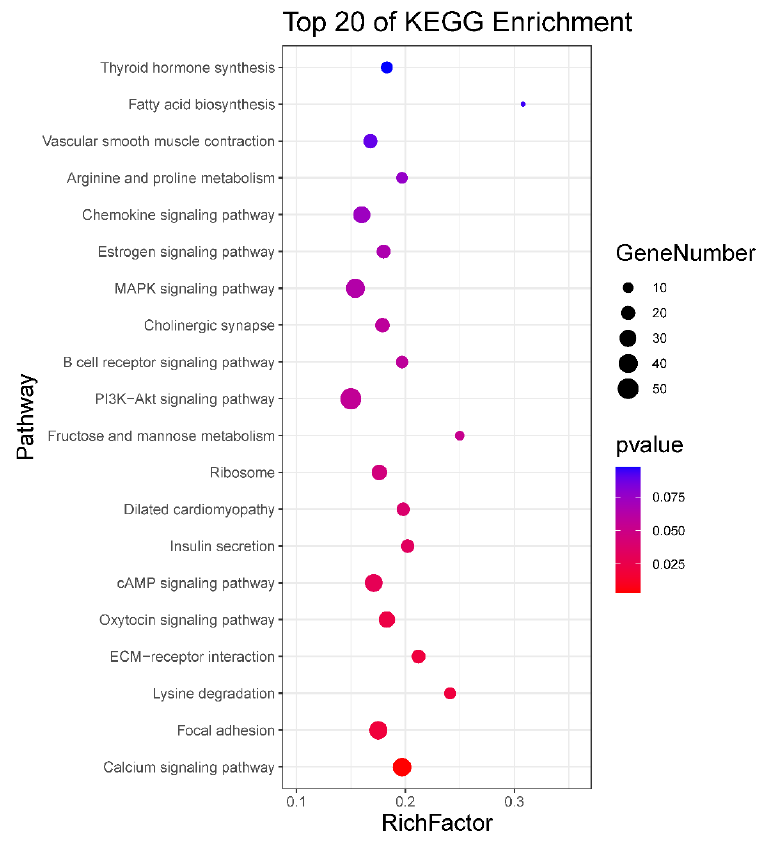
Figure 2. KEGG enrichment analysis for target gene of DE miRNAs. The top 20 enriched KEGG pathways are listed for target gene of DE miRNAs.